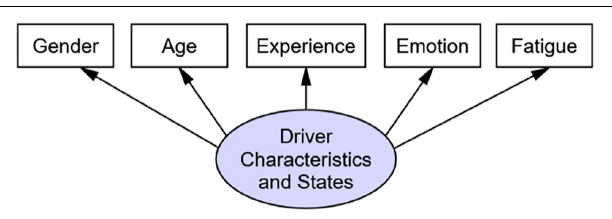
FIGURE 1 | Measurement sub-model for driver characteristics and states variable as